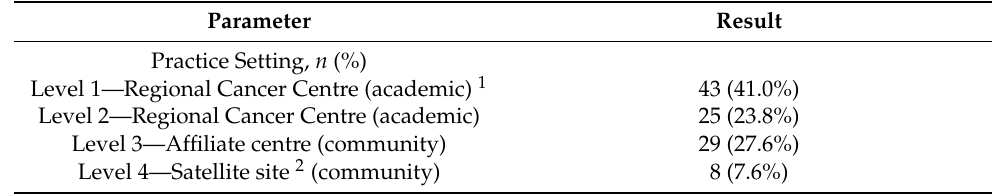
Table 2. Distribution of responses by practice setting, region, and tumor type ( n =